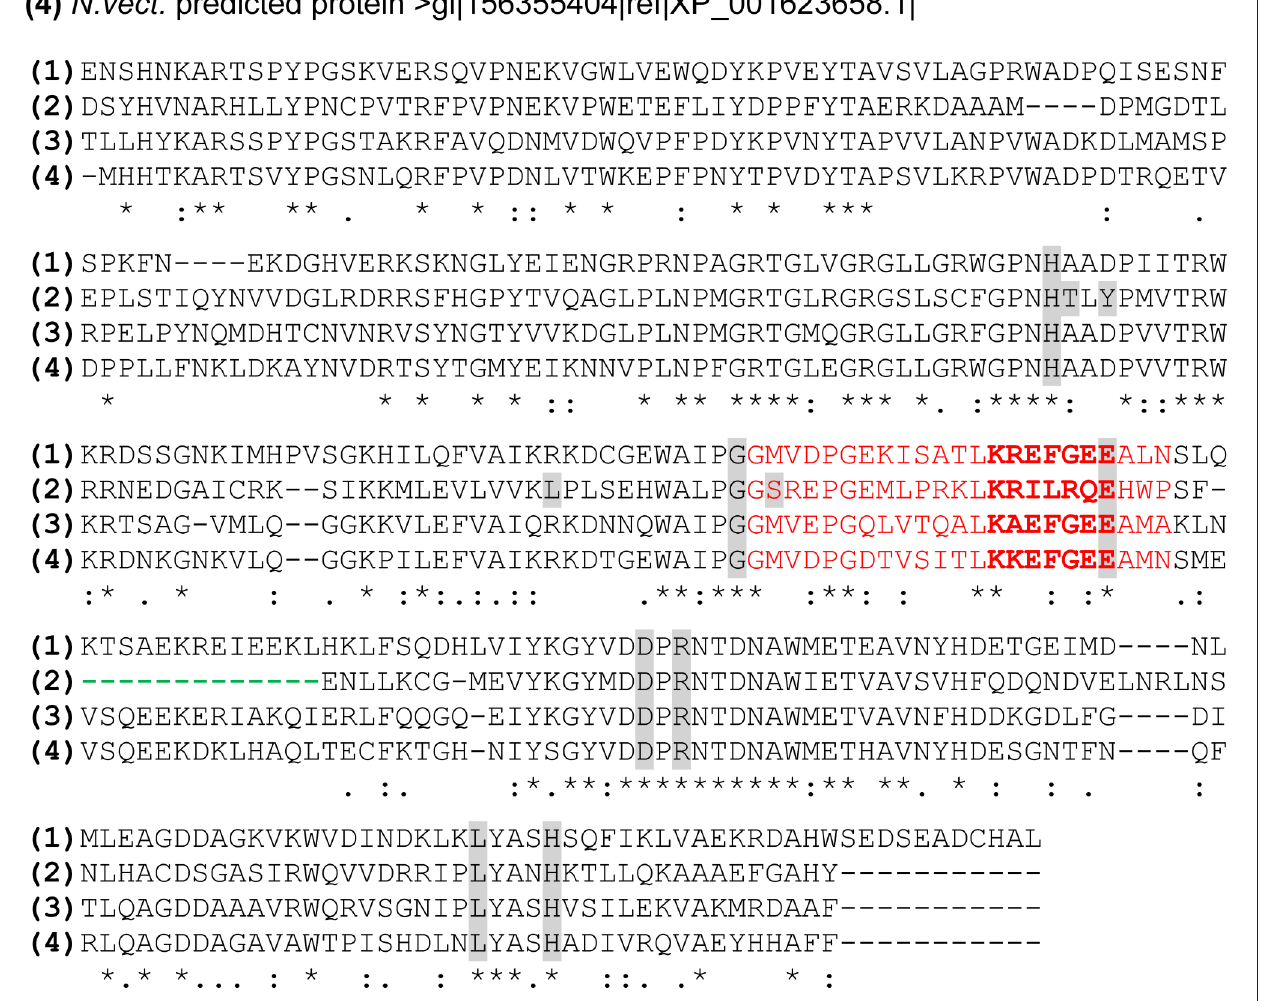
FIGURE 1 | Multiple Sequence alignment of the NUDT9-related channel domains of h TRPM2 and nv TRPM2 and the NUDT9 enzymes of man and sea anemone. Alignment was performed (using the tool at www.uniprot.org/align/) with amino acid sequences of the human NUDT9 enzyme (aa 59–350) the NUDT9 homology (NUDT9H) domains of human TRPM2 (aa 1236–1503) and sea anemone TRPM2 (aa 1,271–1,551) as well as of the putative NUDT9 enzyme of the sea anemone (aa 1–281). The NUDIX sequence motif containing the catalytic active site (bold) is given in red. The functionally important deletion downstream of the NUDIX box which is exclusively present in h TRPM2 is indicated with a green dashed line. Individual residues found to be directly involved in the binding of ADP-ribose in h TRPM2 (Yu et al., 2017) are in gray. Most of these residues are conserved in the corresponding region of nv TRPM2 and the NUDT9 enzymes. Symbols (*, :, .) denote the degree of conservation observed in each column as specified on the website indicated